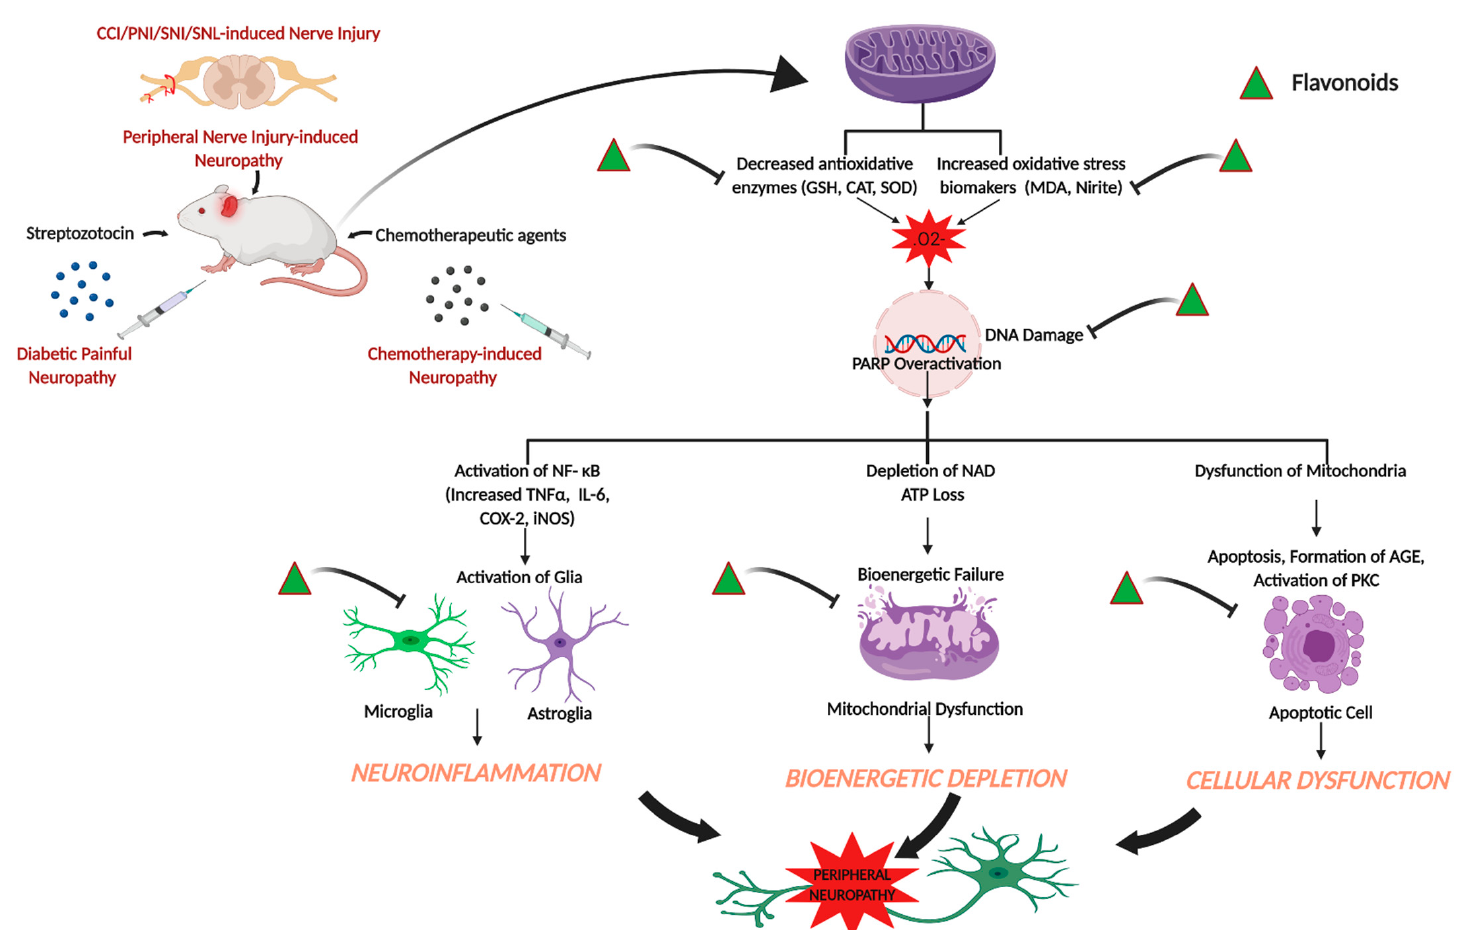
Figure 1. Effects of flavonoids on peripheral neuropathic conditions. Flavonoids attenuate different peripheral neuropathic pain conditions by inhibiting or downregulating different neuroinflammatory, cellular, bioenergetic and oxidative stress markers. The illustration was created with BioRender (http://BioRender.com).